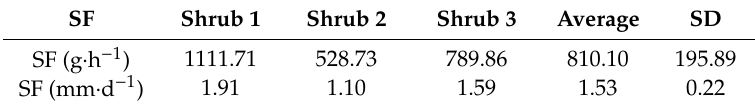
Figure 8. Comparison of the measured and estimated SF values using the remaining 30% of the validation dataset. Table 3. Estimation of individual-scale SF for the three C. korshinskii plants.